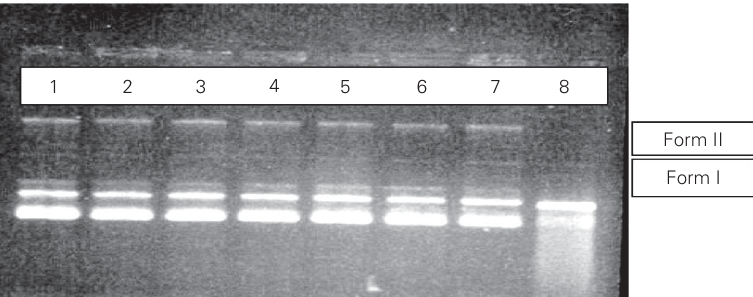
Figure 1. Ginkgo biloba crude extract (EGb) protects pUC 9.1 plasmid DNA from degrada- tion by SnCl 2 . After incubation at pH 7.4, plasmid plus EGb (lanes 3-6) or plasmid plus EGb plus 200 µg/ml SnCl 2 (lane 7) were submitted to agarose gel electrophoresis. Lane 1 = H 2 O control containing plasmid, Lane 2 = saline control containing plasmid. The amount of EGb was 0.4 mg/ml (lane 3), 4.0 mg/ml (Lane 4), 20 mg/ml (lane 5), 40 mg/ml (lane 6), and 200 µg/ml SnCl 2 (lane 8). I = supercoiled form; II = open circle